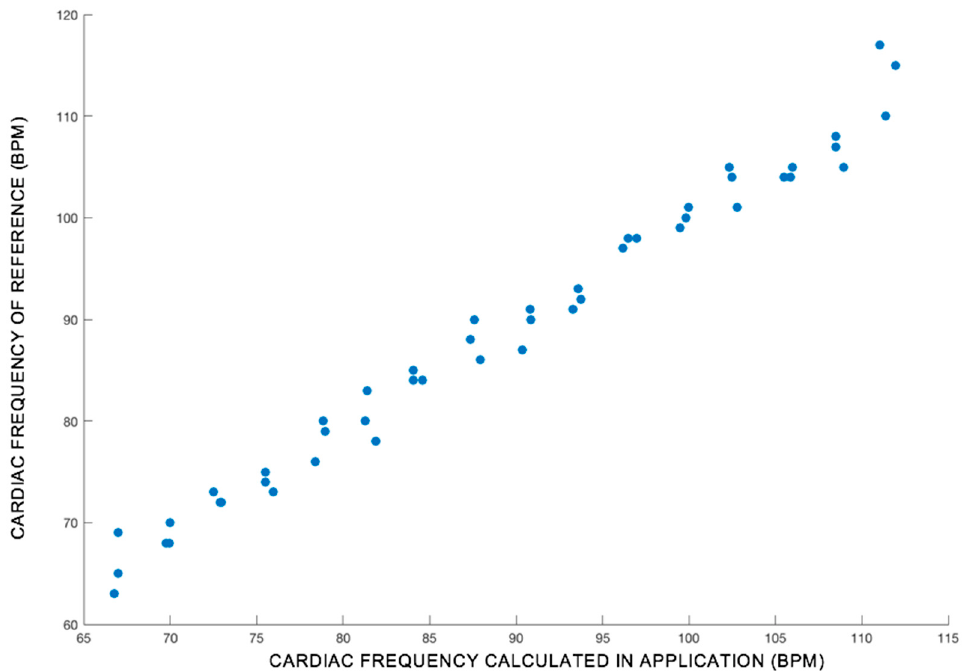
Figure 7. Relationship between the two methods, the reference values, and the values obtained by our application.